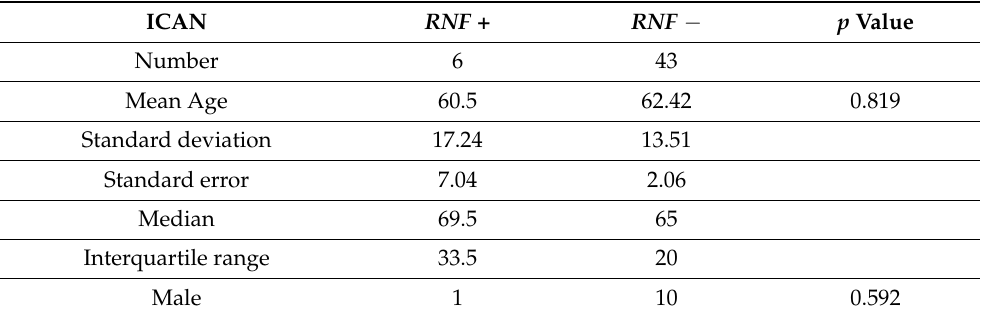
Table 3. Characteristics of cases with and without RNF213 (c.14576G>A) in internal carotid